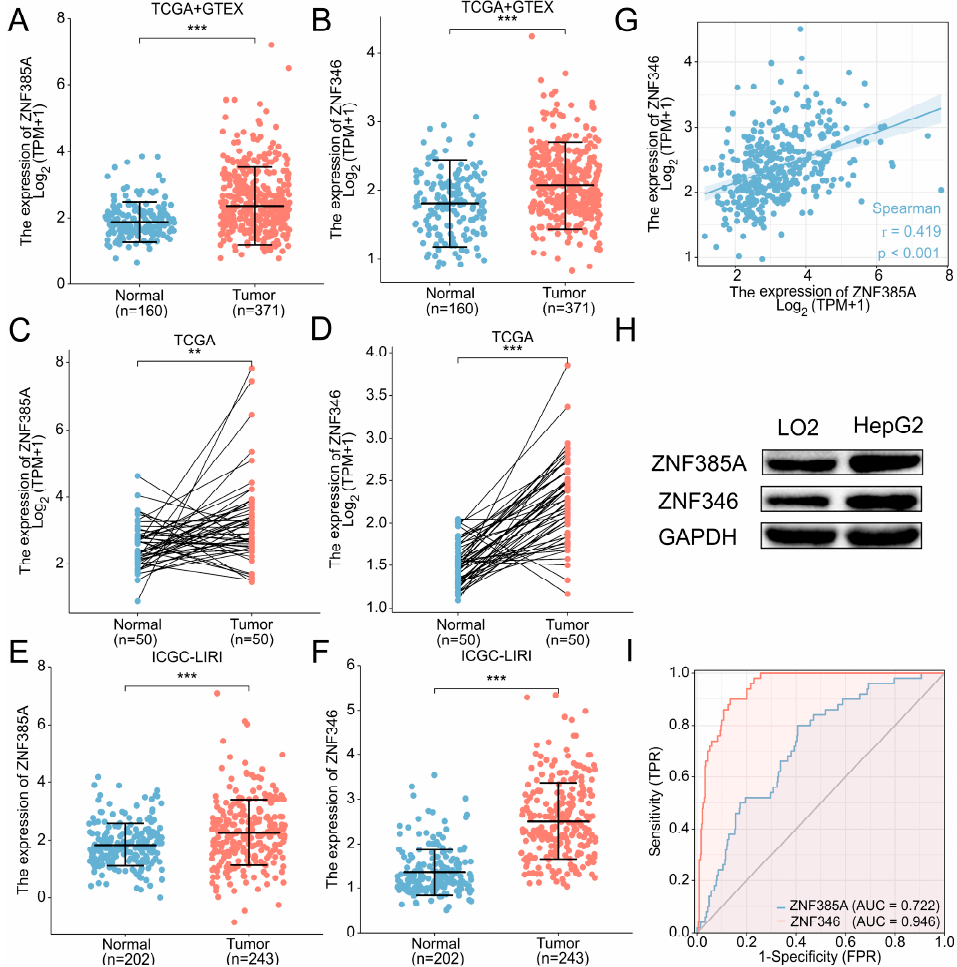
Figure 2. ZNF385A and ZNF346 are overexpressed in HCC, and their diagnostic potential. ( A , B ) ZNF385A and ZNF346 mRNA expression in 371 HCCs, and 160 adjacent normal tissues from the TCGA and GTEx databases. ( C , D ) ZNF385A and ZNF346 mRNA expression in paired tumor and adjacent normal tissues of 50 patients with HCC in TCGA. ( E , F ) ZNF385A and ZNF346 mRNA ex- pression from the ICGC database. ( G ) Correlation scatter plot of ZNF385A and ZNF346 . ( H ) Valida- tion of ZNF385A and ZNF346 protein levels in normal liver cell (LO2) and HCC cell (HepG2) via Western blot analysis. ( I ) ROC curves to test the diagnostic value of ZNF385A and ZNF346 . ** p < 0.01; *** p < 0.001.